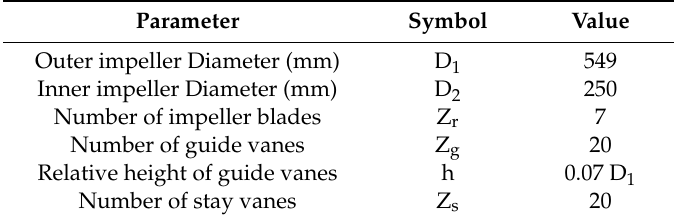
Table 1. Geometric parameters of the investigated